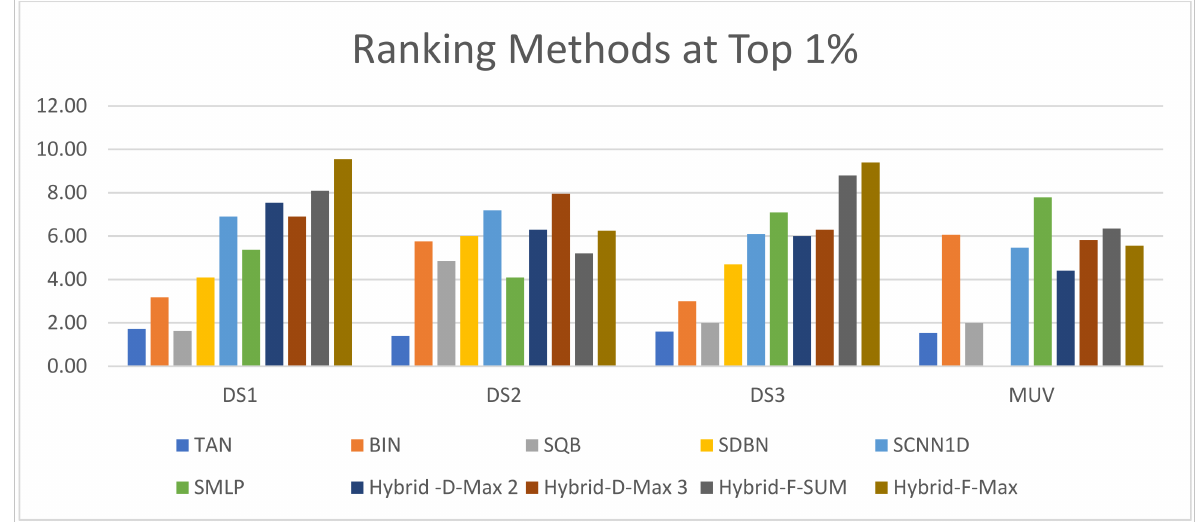
Figure 16. The ranking methods at the top 1%.